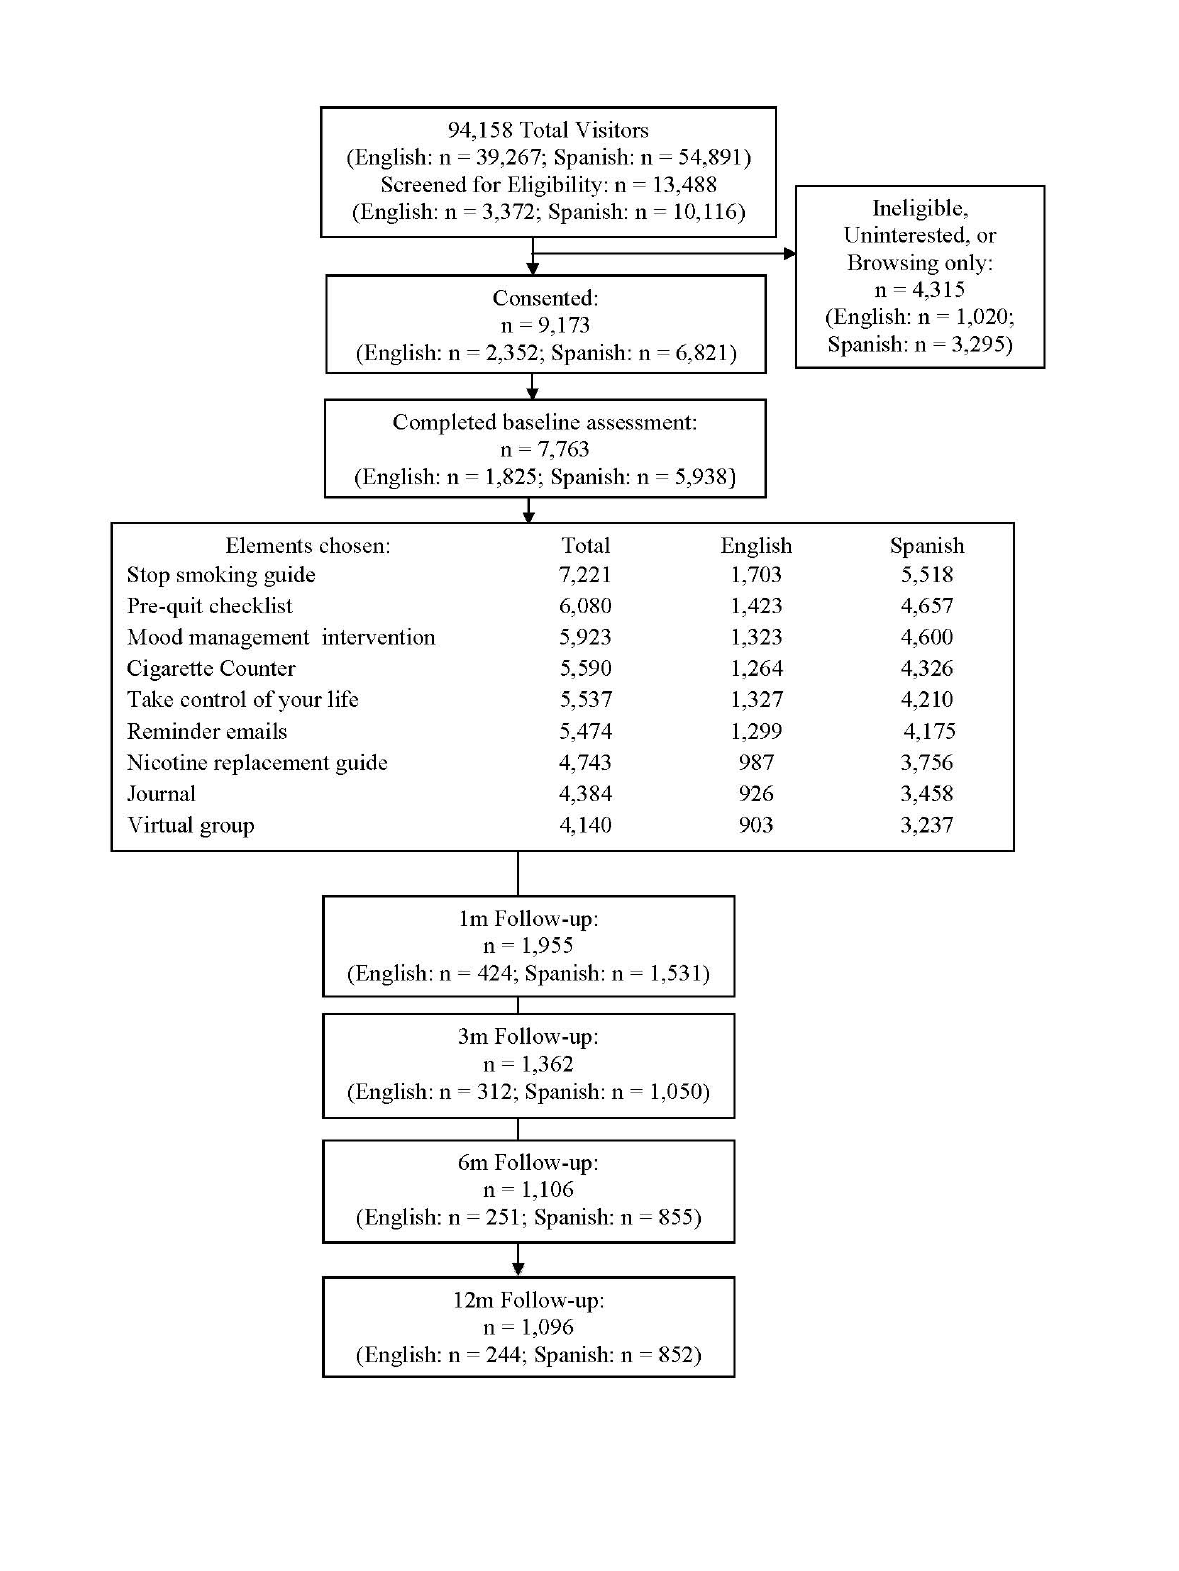
Figure 1. Progression of participants through the San Francisco Stop Smoking participant preference site, with follow-up at 1 month (1m), 3 months (3m), 6 months (6m), and 12 months